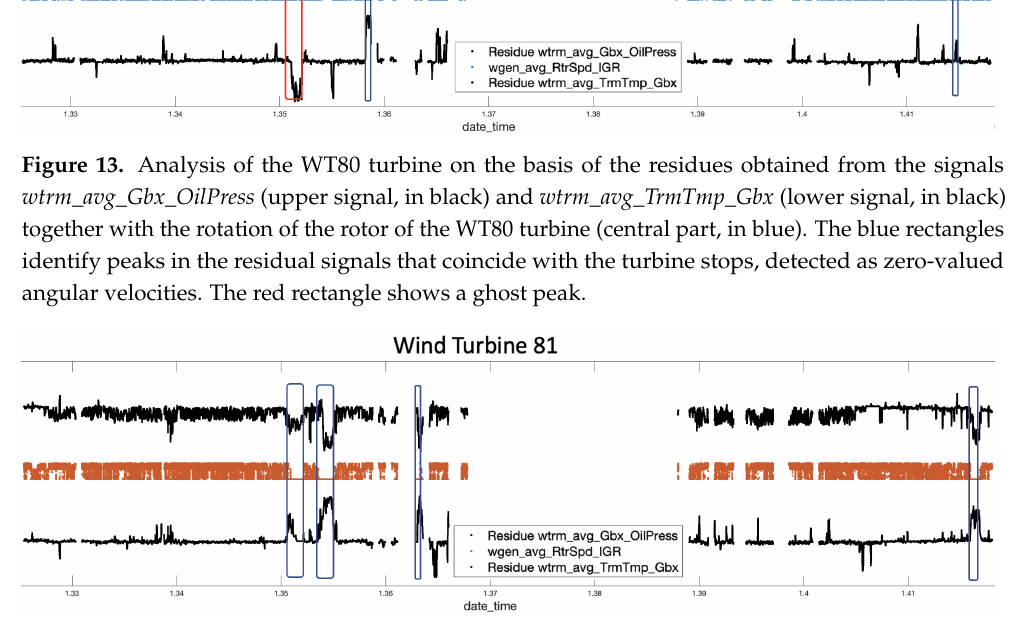
Figure 14. Analysis of the WT81 turbine on the basis of the residues obtained from the signals wtrm_avg_Gbx_OilPress (upper signal, in black) and wtrm_avg_TrmTmp_Gbx (lower signal, in black) together with the rotation of the rotor of the WT81 turbine (central part, in blue). The blue rectangles identify peaks in the residual signals that coincide with turbine stops, detected as zero-valued angular velocities.